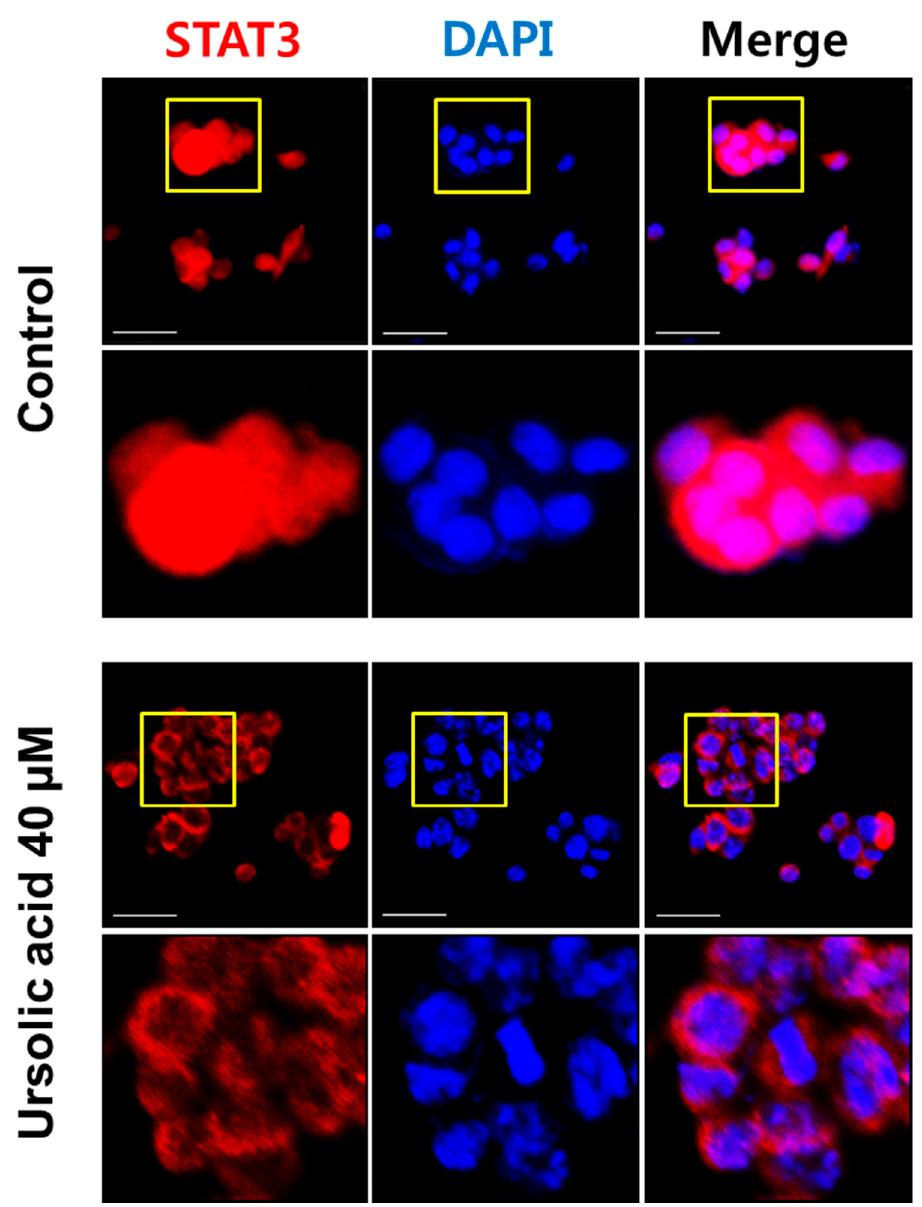
Figure 3. Nuclear translocation of STAT3 was suppressed by ursolic acid in HCT116 cells. The localization of STAT3 (red) and 4,6-diamidino-2-phenylindole (DAPI) (blue) in HCT116 cells. HCT116 cells were treated by ursolic acid for 24 h. STAT3 was probed with primary antibody and labelled using secondary antibody conjugated. Scale bar = 40 μ m. Corresponding zoomed images of the STAT3, DAPI, and Merge (indicated by the yellow box).